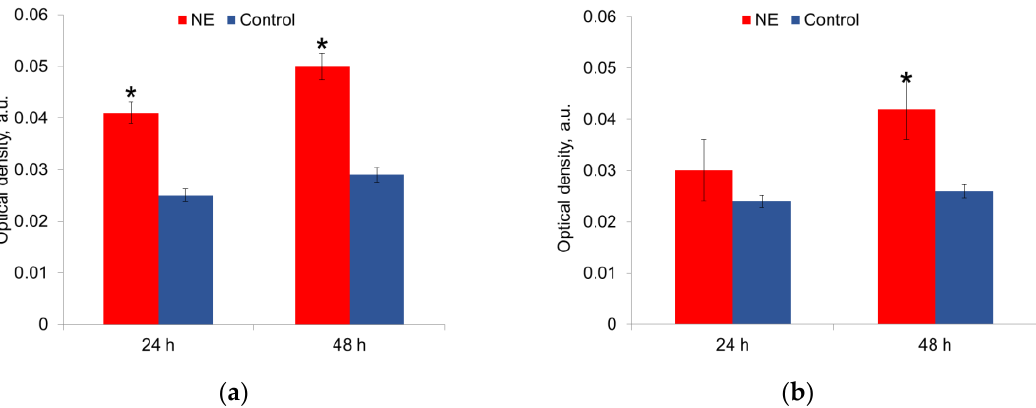
Figure 4. NE effect on matrix production by E. coli ( a ) and S. aureus ( b ) in 24 h and 48 h of incubation. * — statistically significant differences in comparison with the control.